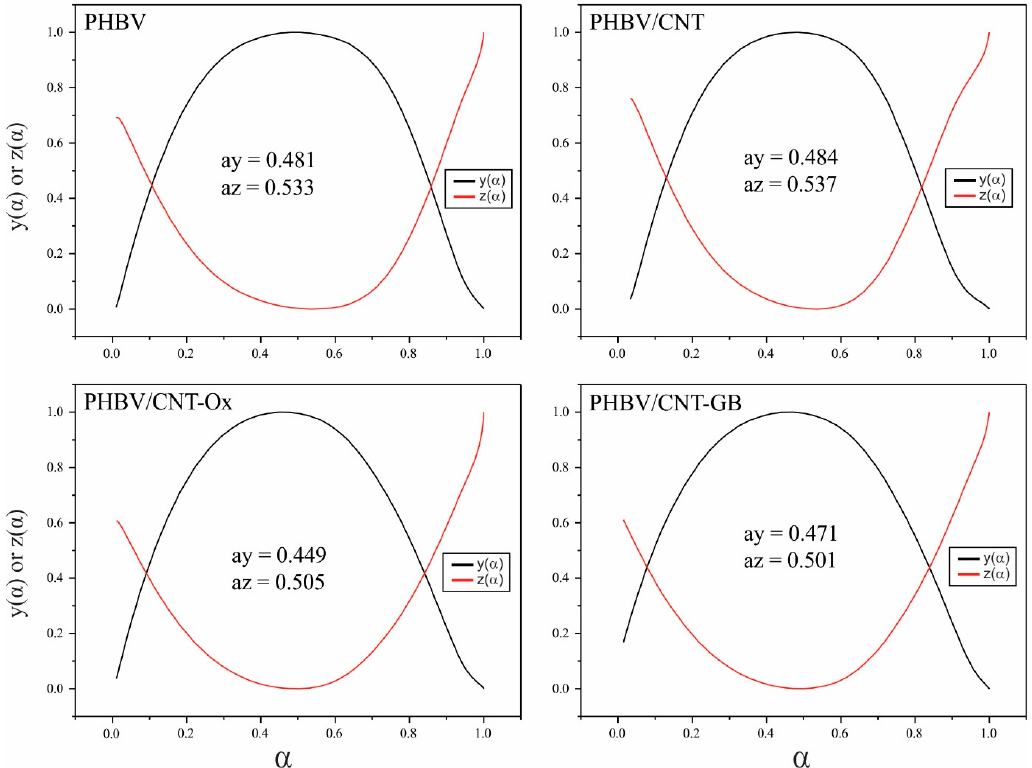
Figure 7. y( α ) and z( α ) normalized curves as a function of the conversion fraction for PHBV, PHBV/CNT, PHBV/CNT-Ox and PHBV/CNT-GB.